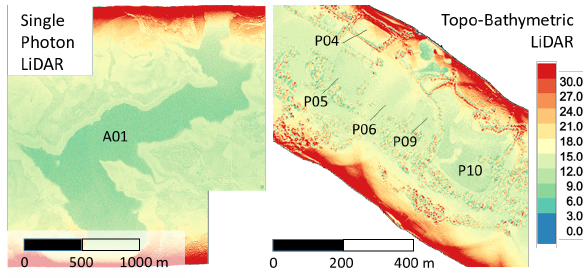
Figure 4. Color coded point density maps for Single Photon (left) and Multi-Photon LiDAR